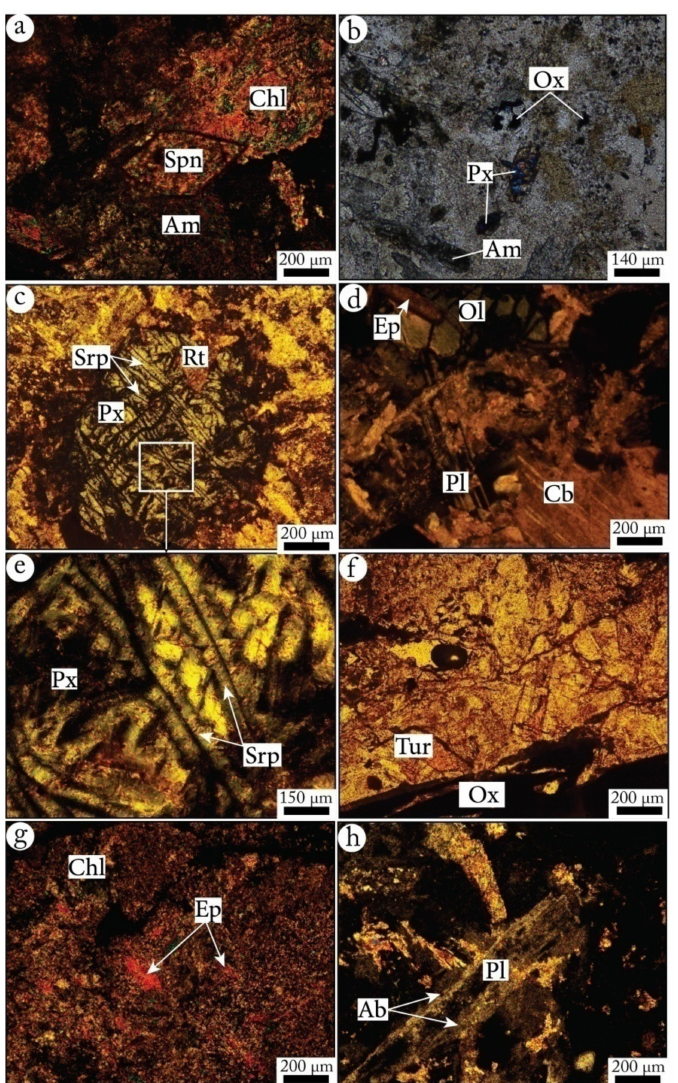
Figure 11. ( a – h ) Microphotographs of the alteration phases of the olivine-bearing gabbros: sericitized (Ser) and albitized (Ab) plagioclase (Pl), amphibolitized (Am) and epidotized (Ep) pyroxene (Px), serpentinized (Srp) and chloritized (Chl) olivine (Ol), tourmaline (Tur) and oxides (Ox) (transmitted light—crossed